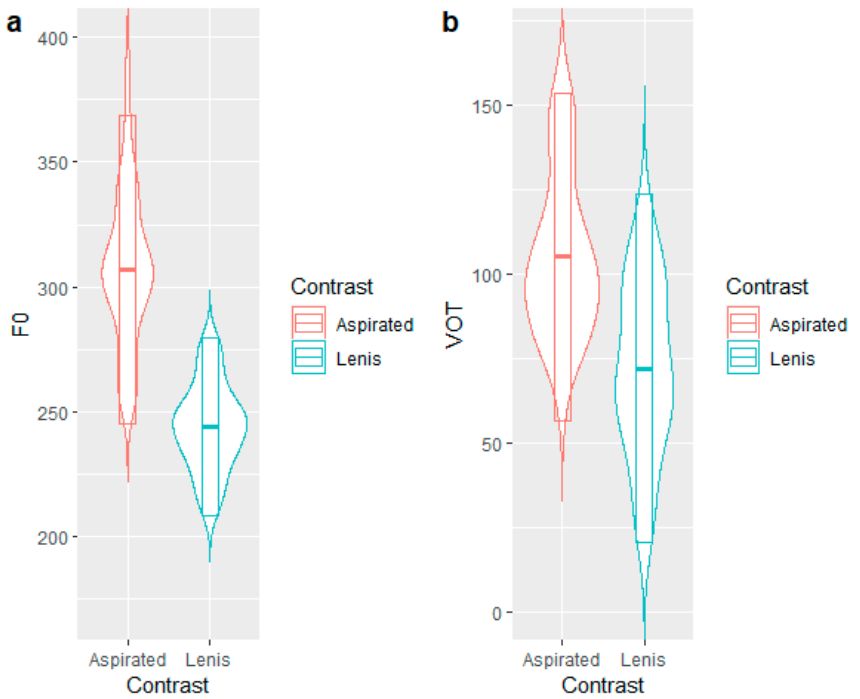
Figure 1. Violin plots of the lenis–aspirated stop contrast in the stimuli. ( a ) shows the comparison of F0, and ( b ) shows the comparison of